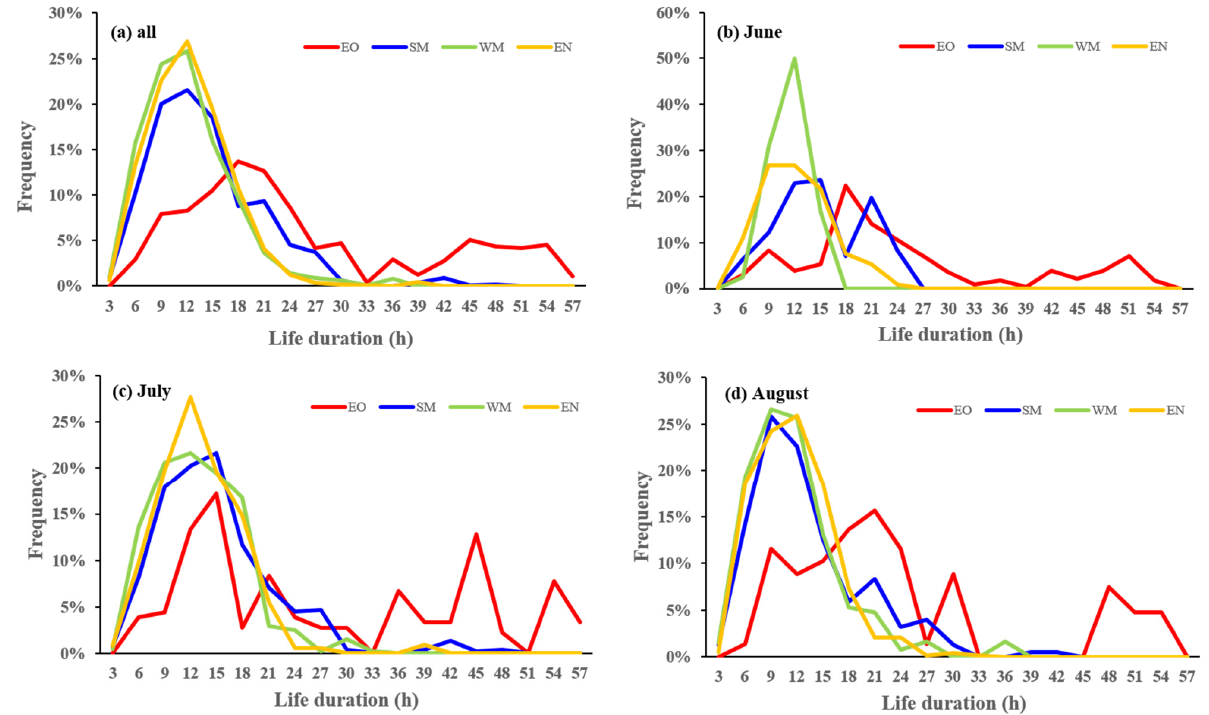
Figure 7. Life duration distribution of EOs (red), SMs (blue), WMs (green) and ENs (yellow). ( a ) Whole summer; ( b ) June; ( c ) July; ( d ) August.